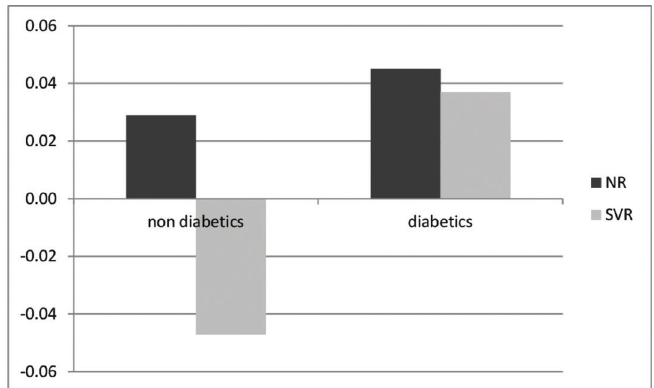
Figure 1 - Variation rate of LS measurements with respect to the diagnosis of diabetes mellitus in sustained virological response (SVR) and non-responder (NR) patients.